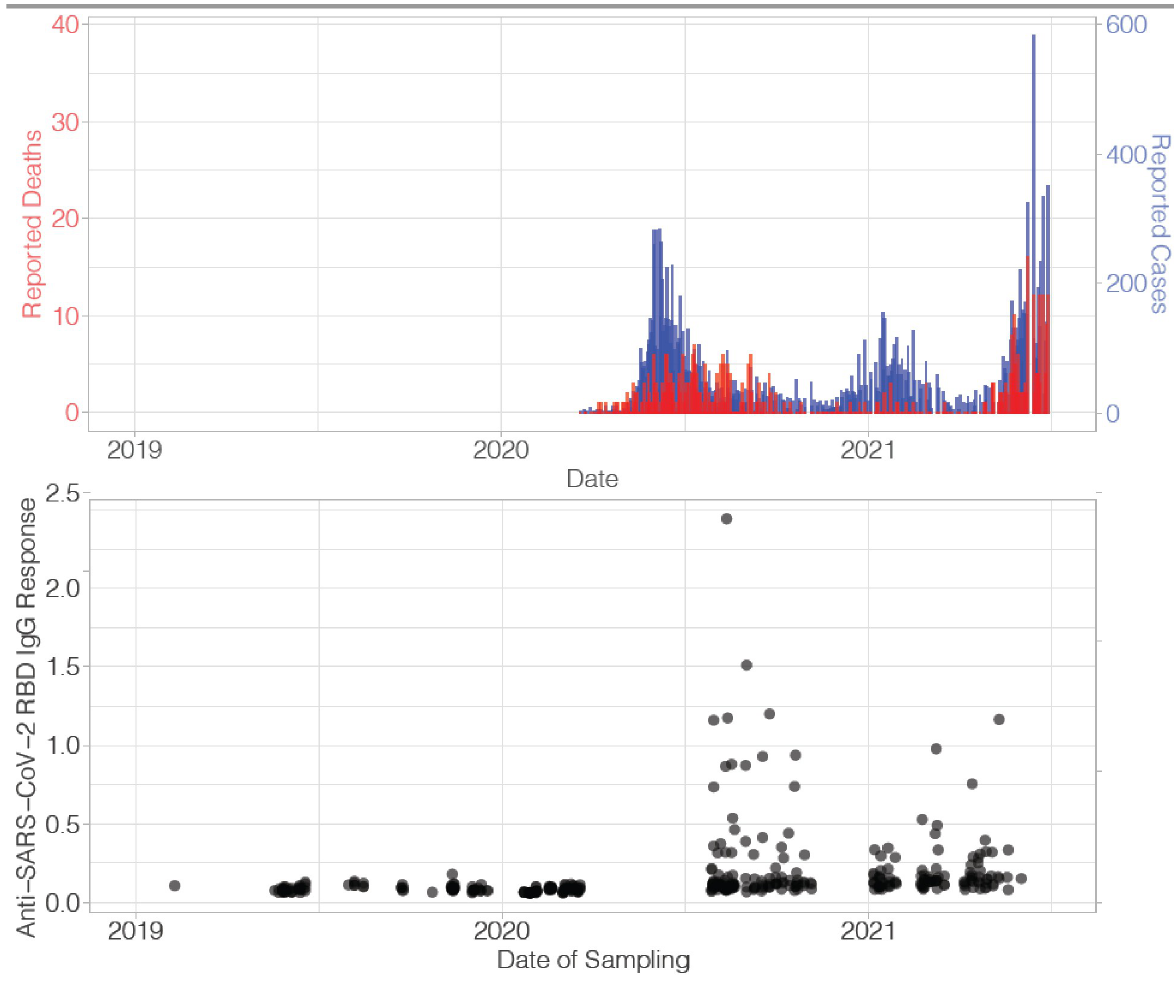
Fig 1. Reported cases (blue) and deaths (red) due to SARS-CoV-2 in Haiti (top) and optical density from ELISA that measures the antibody to SARS-CoV-2 Receptor Binding Domain IgG (bottom) by date of sampling for Haitian infants born between March 2019 and May 2021 and followed for up to 30